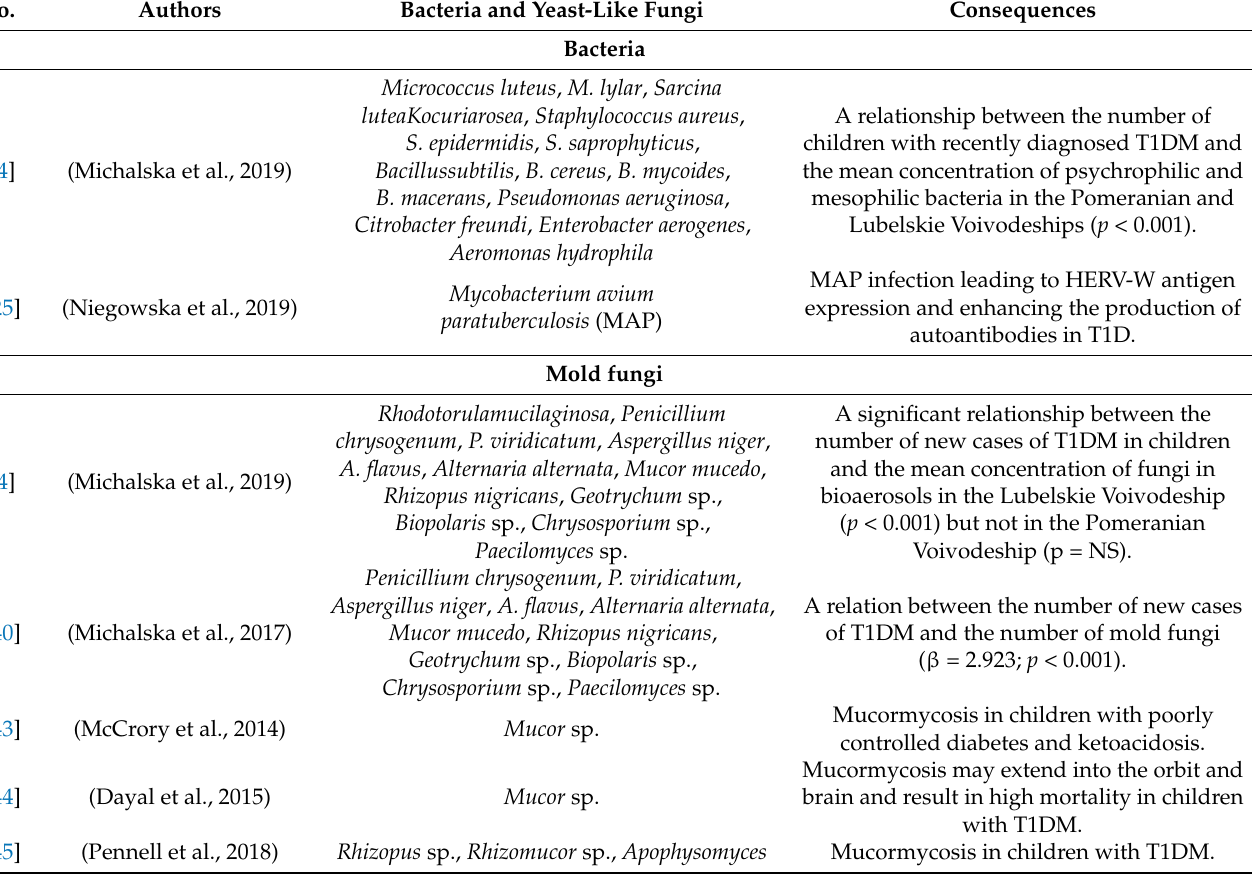
Table 3. The role of bacteria and yeast-like fungi in the development of type 1